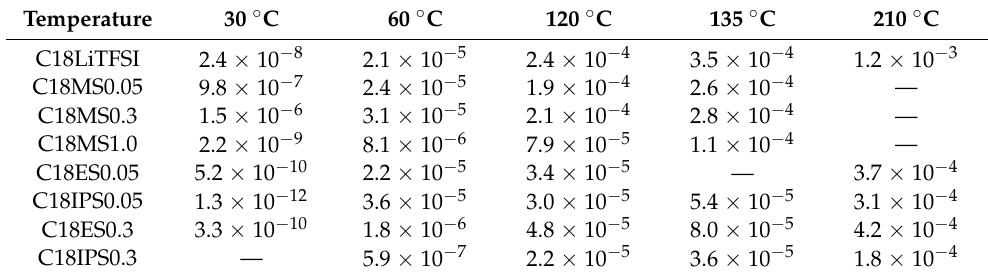
Table 5. Values of DC conductivity in S/cm across C18MS ratios in the crystalline, smectic and isotropic phases. “—” indicates a measurement was not taken at that temperature. Data for C18LiTFSI were originally reported in